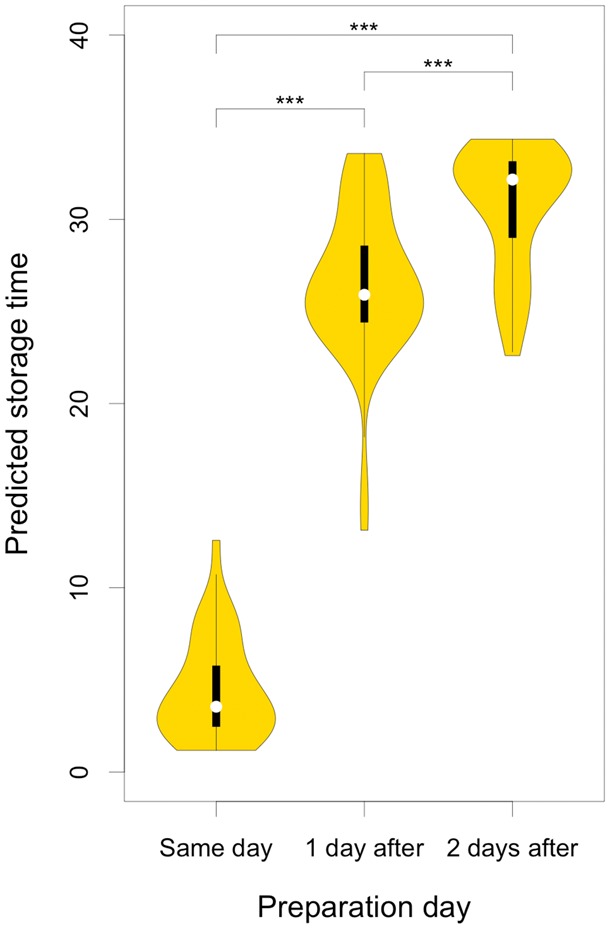
Predicted pre-centrifugation time at 22 °C for external validation samples (n = 111). Samples were prepared on either the same day as sampling, the next day, or the day after that. Predicted pre-centrifugation times were significantly different between levels (P < 2.2e-16). All pair-wise comparisons were significant after Tukey adjustment (P < 0.001)